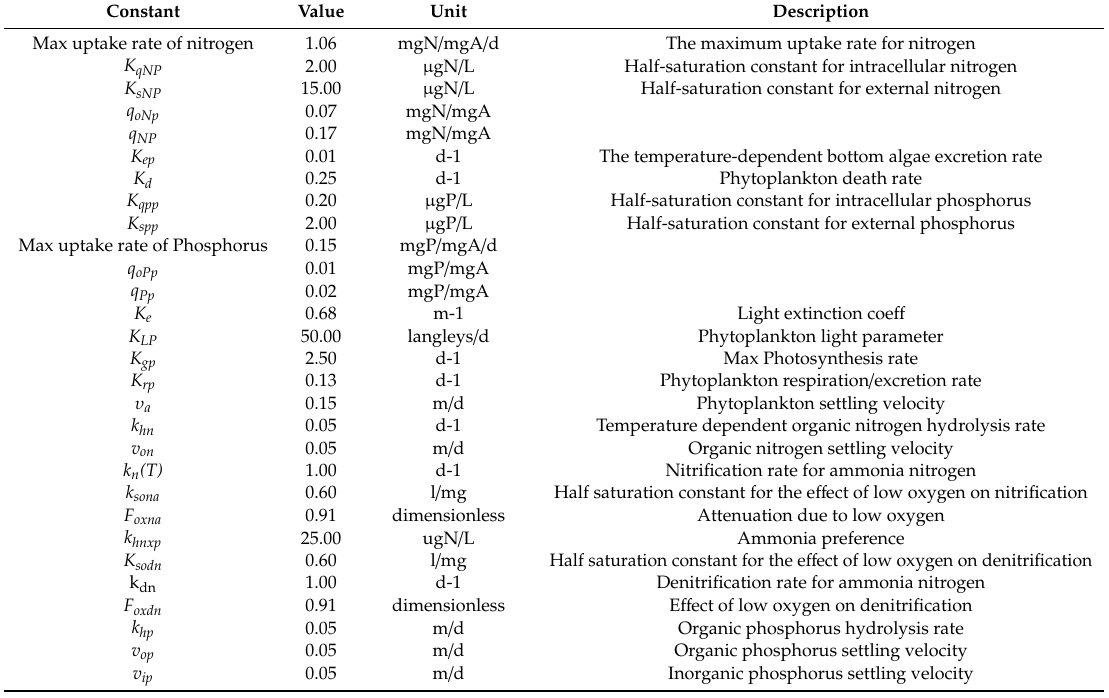
Table 3. Values of constants used in the modeling.